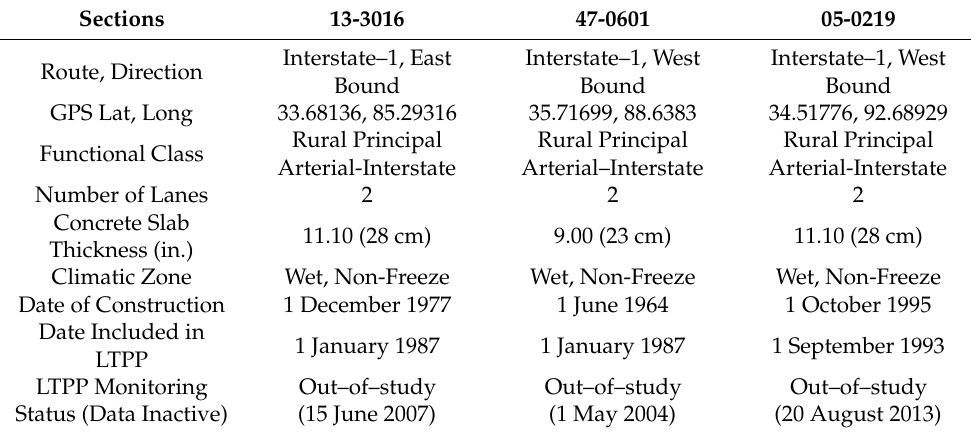
Table 2. The circumstances and physical conditions of selected sections.